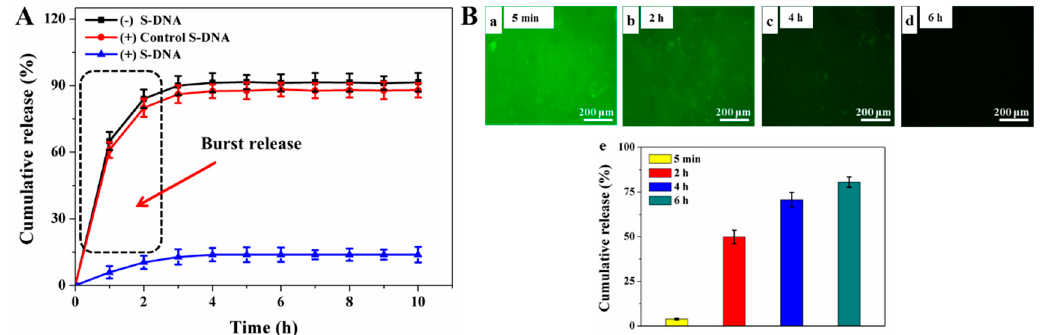
Figure 4. ( A ) Thrombin release from different hydrogels in the absence of the CSs. ( B ) Fluorescent images of hydrogel (with FAM-labeled S-DNA) in the existence of 4 ′ -(4-dimethylaminophenylazo) (DABCYL)-labeled CS15 at different reaction times: (a) 5 min, (b) 2 h, (c) 4 h, and (d) 6 h. (e) Cumulative release of TB at different reaction times. The molar ratio of complementary sequences (CSs) to S-DNA was fixed at 1:1.